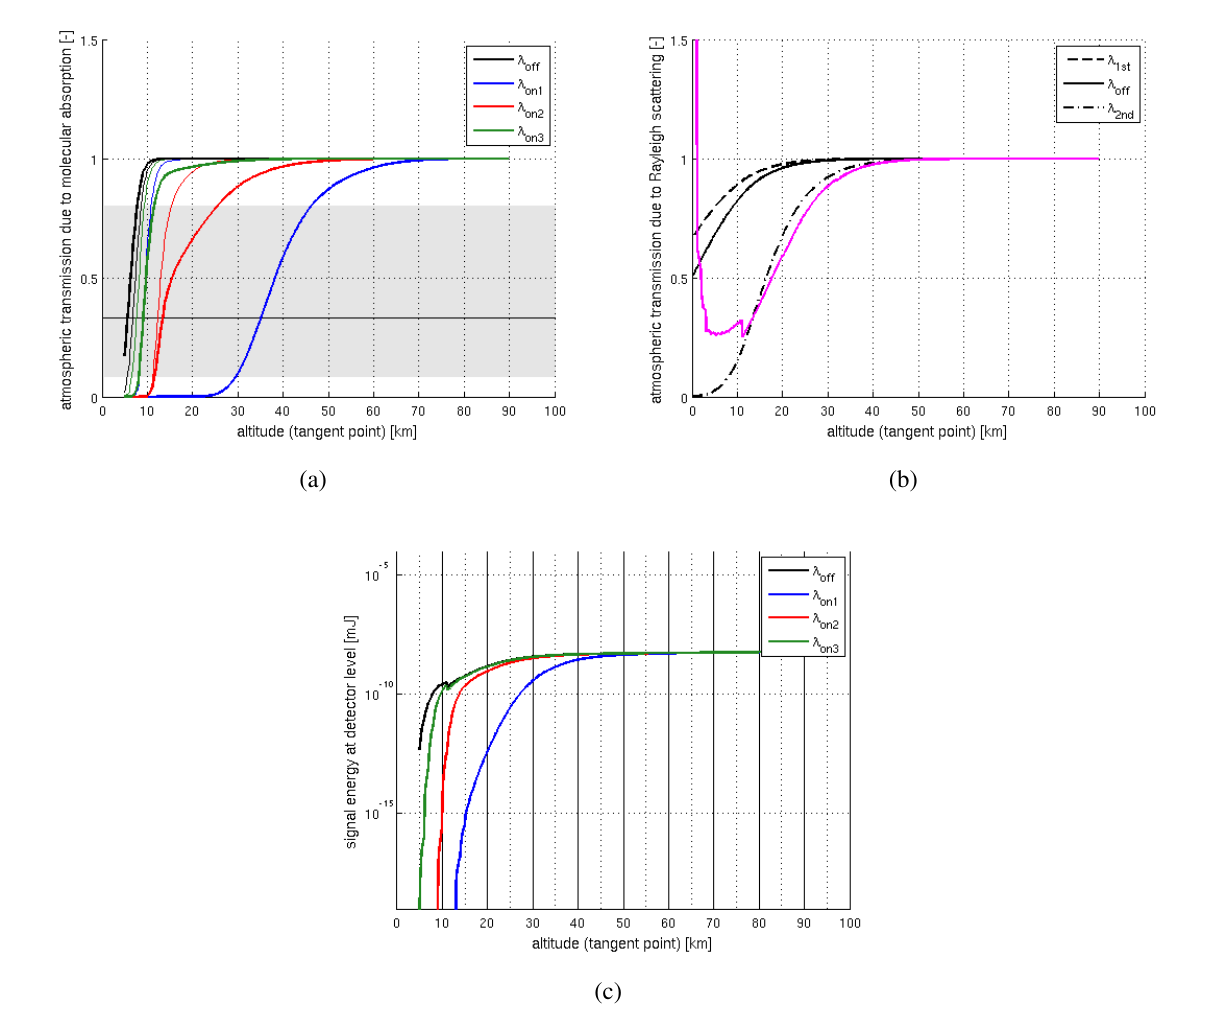
Figure 6. Outcome of preliminary performance assessment for IPDALLS. Altitude is given for the tangent point of the limb sounding optical path, and values below 5 km have not been computed. ( a ) Atmospheric transmission due to absorption on the forward path (thick lines) and on the backward path (thin lines). The shaded area shows the range over which the relative error approximately doubles with respect to its minimum at a transmission of 0.33. ( b ) Atmospheric transmission calculated for Rayleigh scattering alone (black lines) and geometric mean of the forward and backward refractive dilution factor for the offline wavelength (magenta). ( c ) Radiative signal pulse energy returned to receiver and incident upon